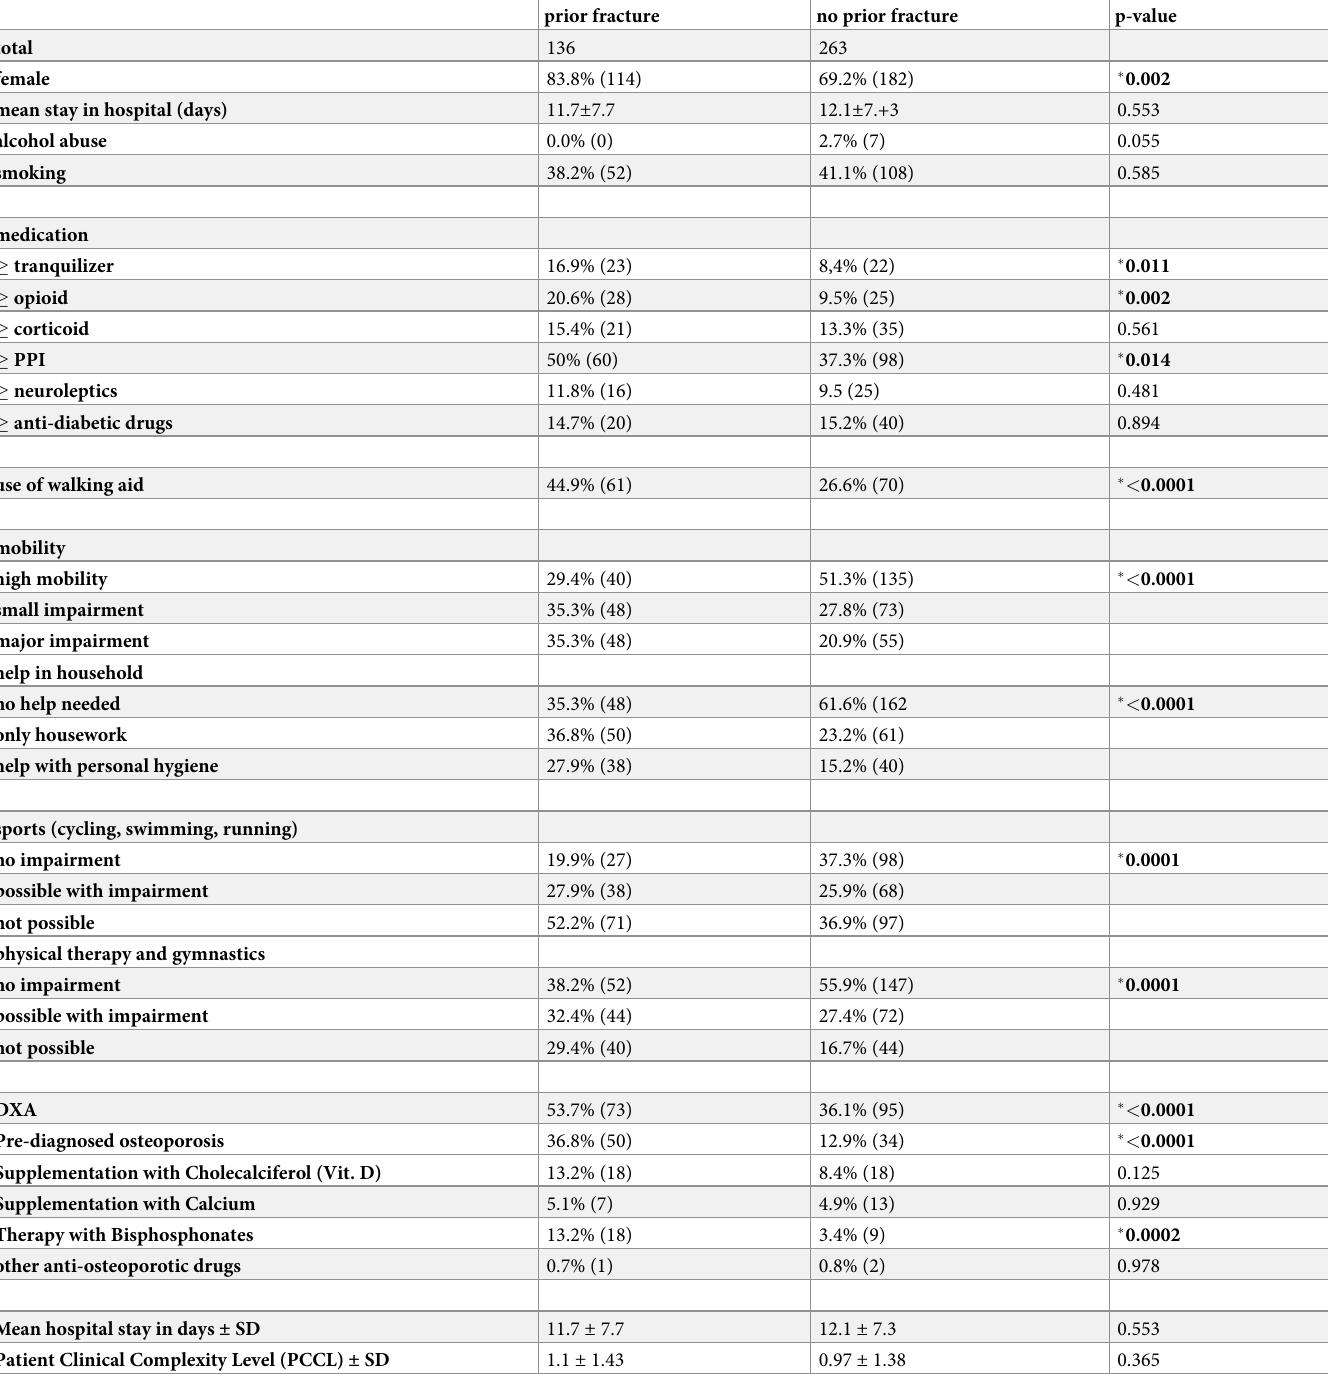
Table 2. Differences in demographics, comorbidities, mobility, diagnosis and treatment of osteoporosis in patients with and without prior risk